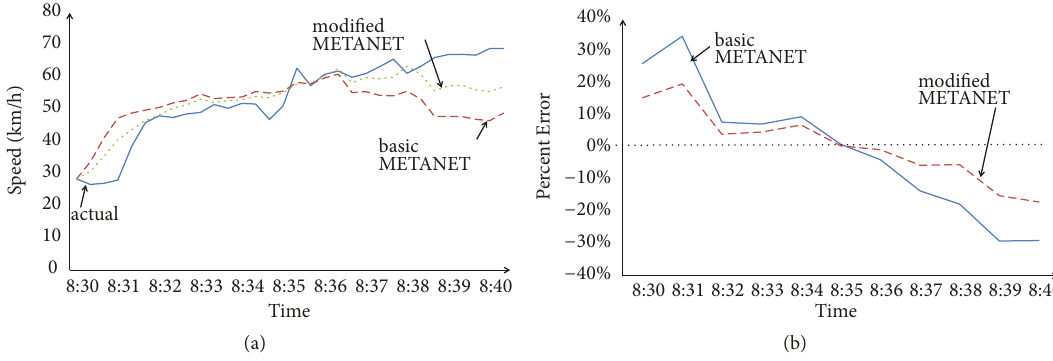
Figure 3: Comparison of speeds of basic and modified METANET models: (a) actual and predicted speeds and (b) percentile prediction error of basic and modified METANET